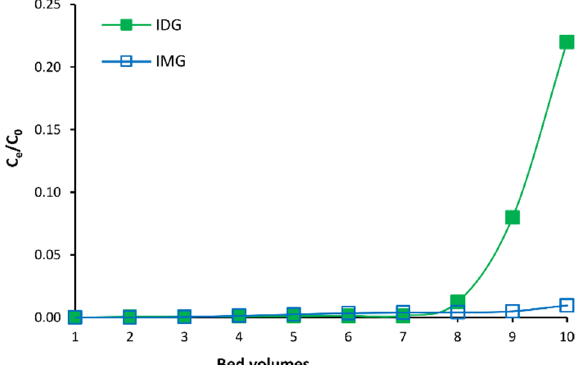
Figure 2. Dynamic breakthrough curves of Cyclopia subternata phenolic compounds on XAD 1180N macroporous resin at 2 BV/h in the small-scale column. Abbreviations: IDG, 3- β - D -glucopyranosyl- 4- O - β - D -glucopyranosyliriflophenone; IMG, 3- β - D -glucopyranosyliriflophenone.